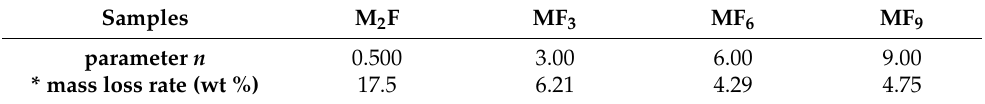
Table 1. Mass loss rates of MF n microspheres in the acid-treatment reaction.